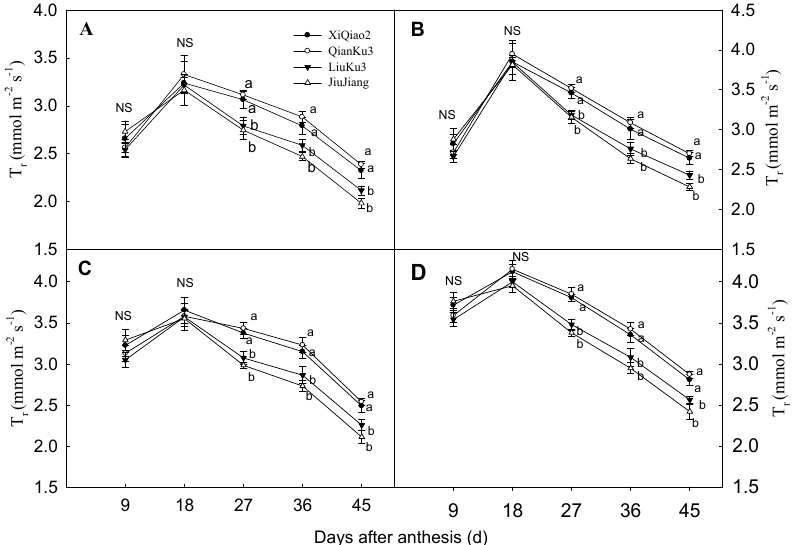
8 of 16 Figure 5. Intercellular CO 2 concentration (C i ) in the leaves of four Tartary buckwheat cultivars at different flowering nodes. Panels ( A )–( D ) show results for the leaves of the 6th, 7th, 8th, and 9th flowering nodes, respectively. Data are the means ± SD of two years (2016 and 2017). Letters a and b denote significant differences between cultivars (p < 0.05) in G S at the same day after anthesis. NS: no